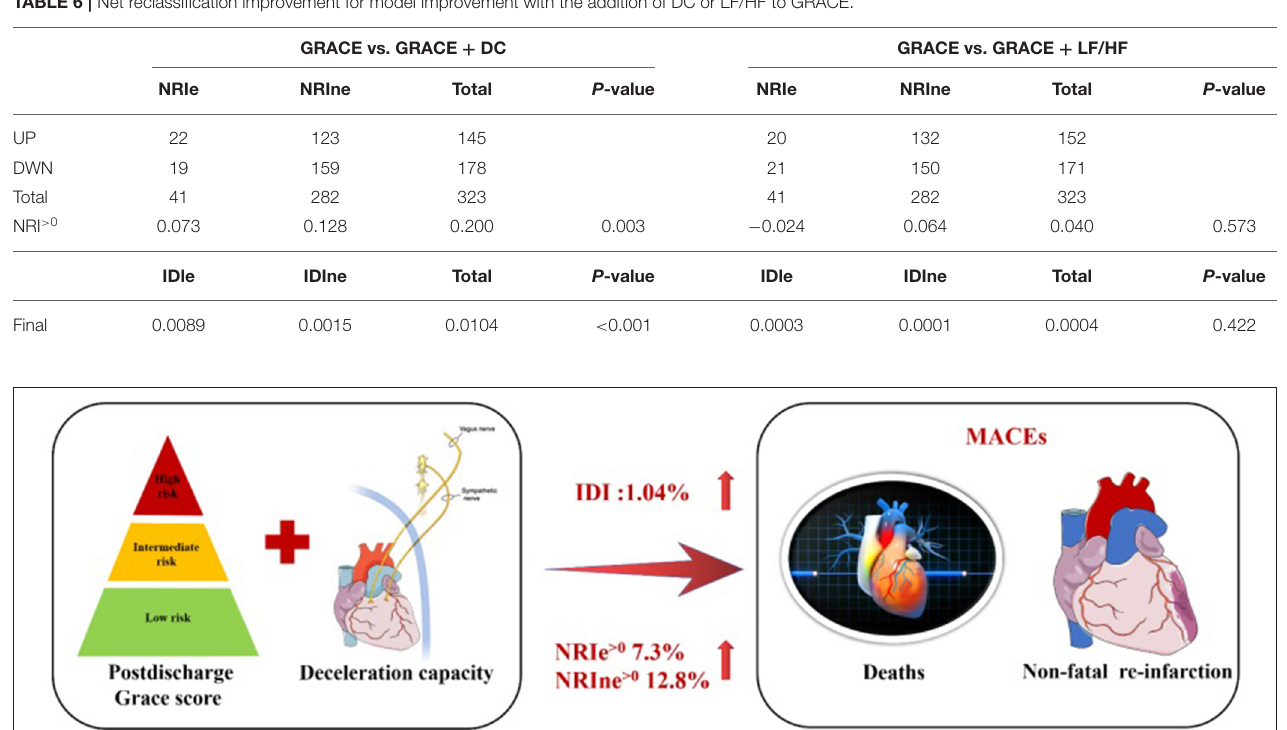
TABLE 6 | Net reclassification improvement for model improvement with the addition of DC or LF/HF to GRACE. GRACE vs. GRACE +